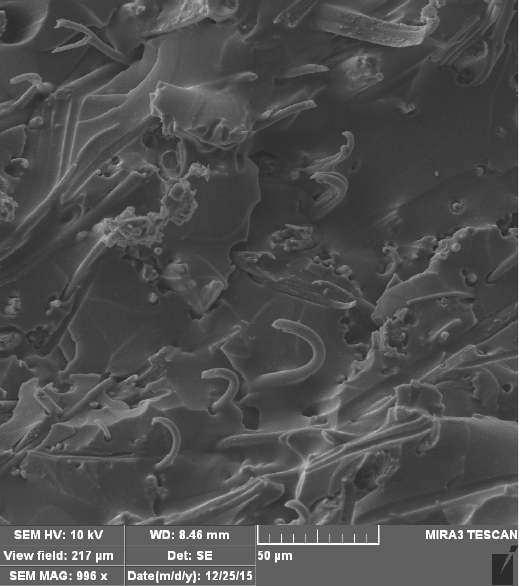
Figure 4. FESEM image of glass fibers–epoxy–PS fibers hybrid composite.